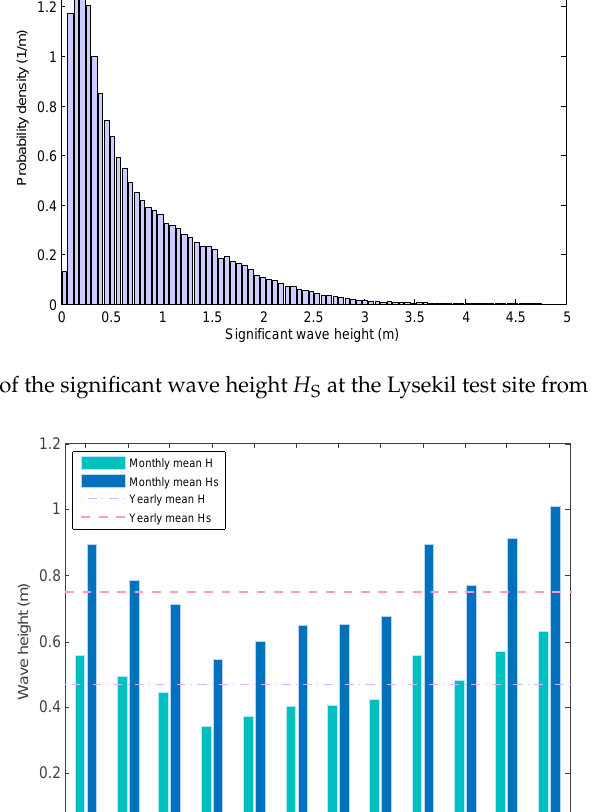
Jan Feb Mar Apr May Jun Jul Aug Sep Oct Nov